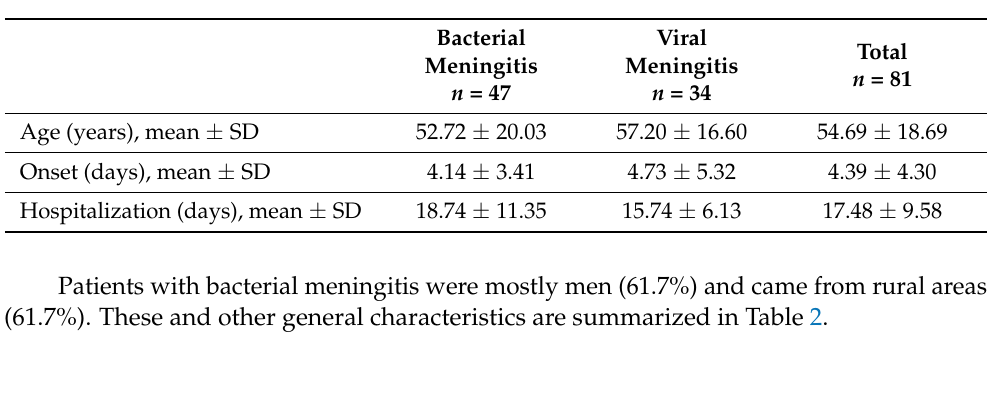
Table 1. General characteristics of